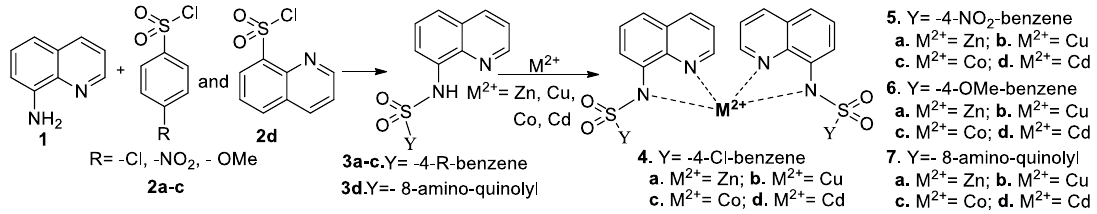
Scheme 2. Reaction pathways to obtain hybrid quinoline-sulfonamide complexes derivatives.